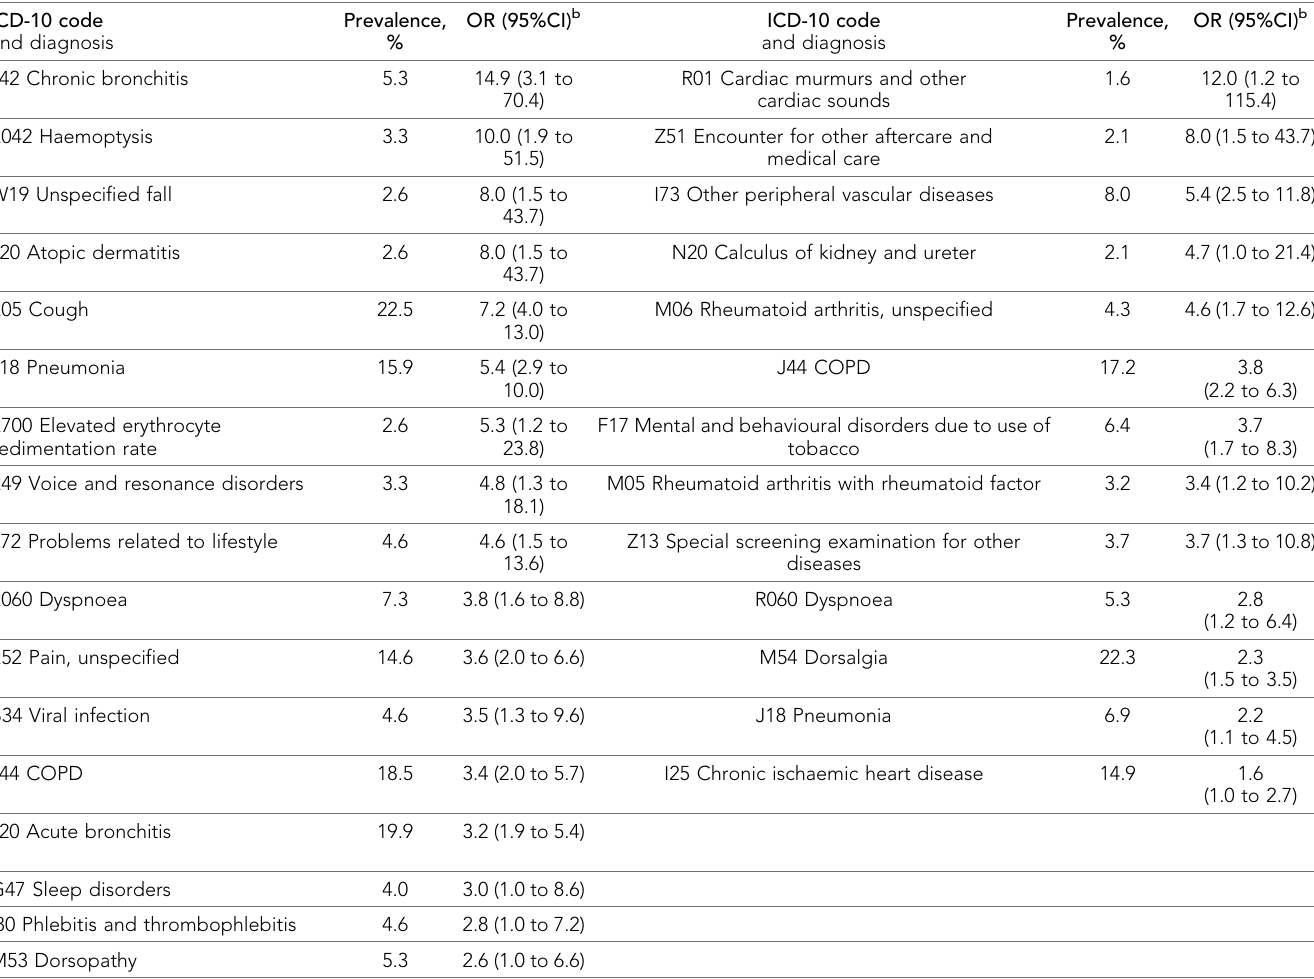
Table 3. Univariate analysis of diagnoses referred from primary or secondary care to the first chest X-ray during 12 months before lung cancer diagnosis a Primary care chest imaging referral ( n =